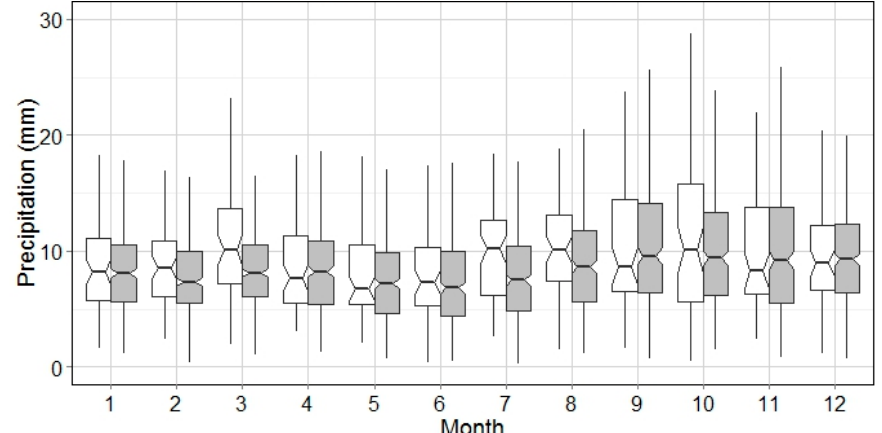
Figure 8. Boxplots of Wet Event Precipitation (WEP) means (Historical: White, Synthetic: grey).